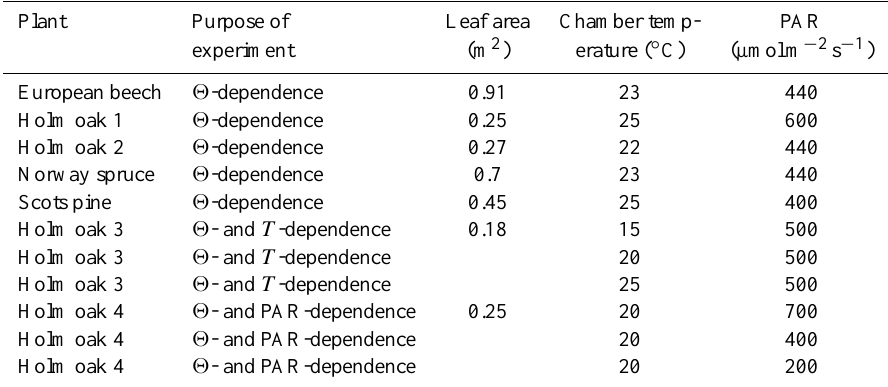
Table 1. List of experiments and chamber